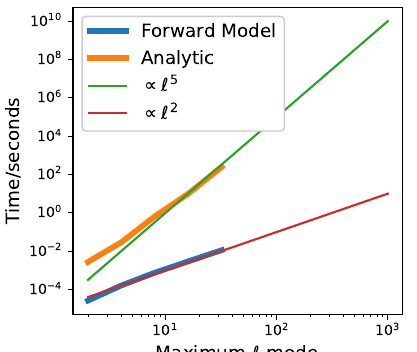
Fig. 3.— Timing of the forward model and analytic calculations using a 2016 Macbook Pro, 3.3 GHz Intel Core i7, 16 GB 2133 MHz LPDDR3. The blue line shows the forward model scaling, the orange line shows the analytic scaling, the thin red and green lines are proportional to L 2 and L 5 respectively where L is the maximum ℓ